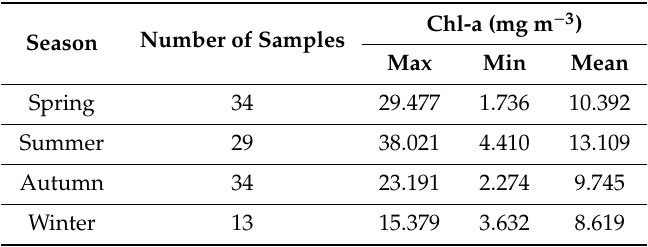
Table 2. Summary of the matchup data used for the performance evaluation of the OC3M algorithm and GROC4 algorithm across seasons in case 2